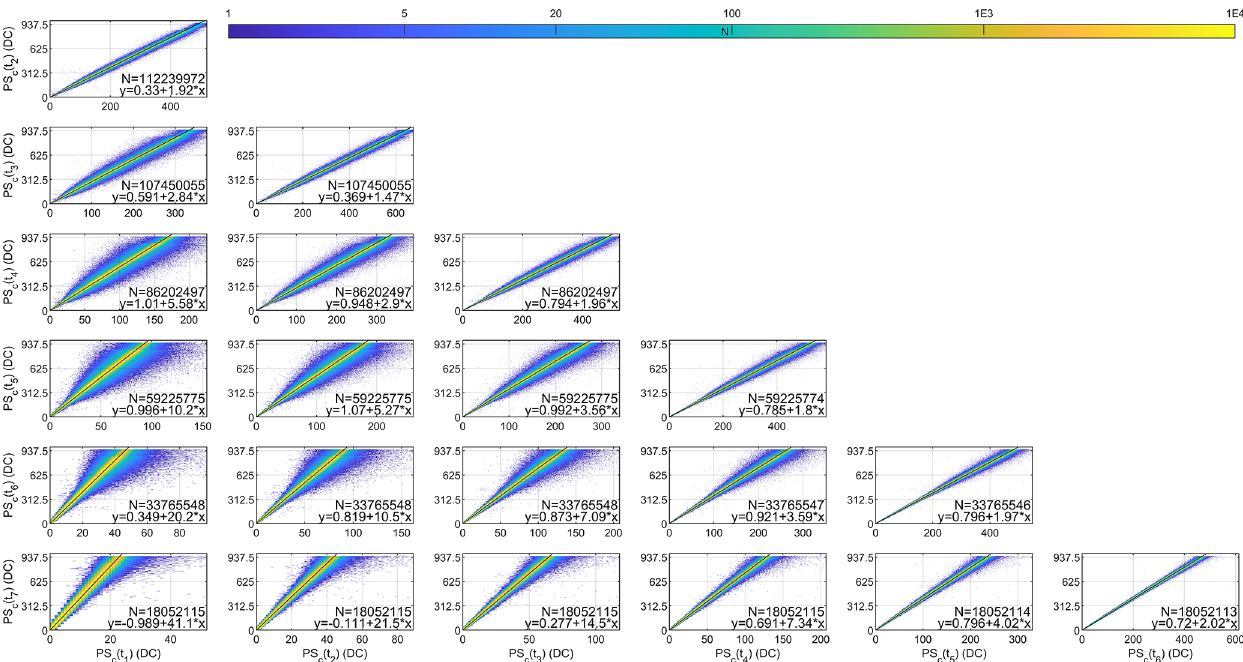
Figure 6. Corrected pixel signal at different exposure times as a function of the corrected pixel signal at other exposure times for all available daytime images on 18 August 2019 at Valladolid. Saturated pixels are not included. The panels show the weighted least squares linear fit and the amount of data ( N